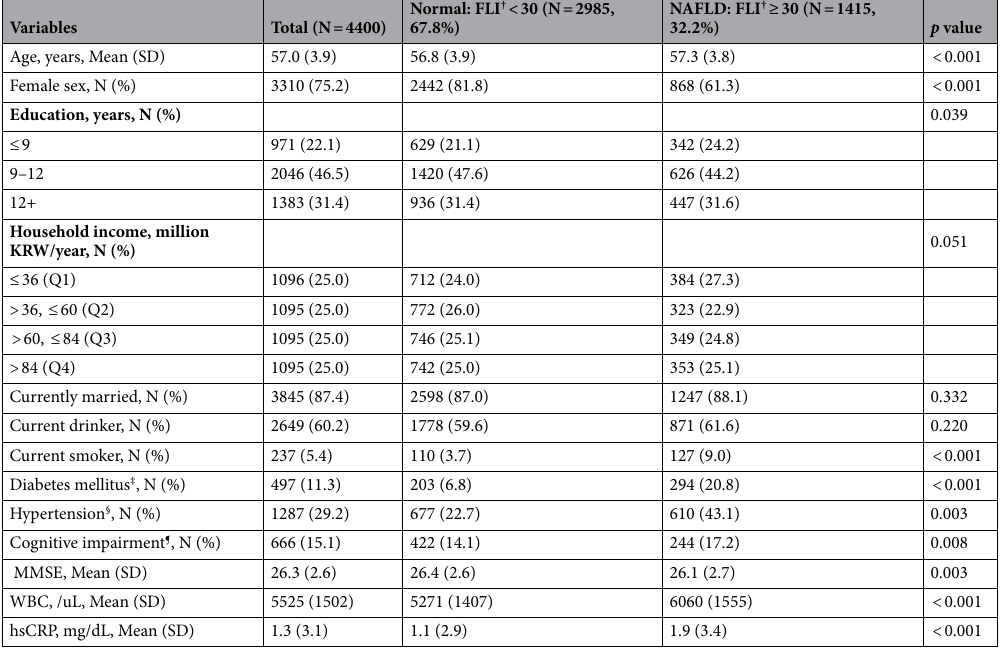
Table 1. Descriptive characteristics of the study population from Cardiovascular and Metabolic Diseases Etiology Research Center cohort (N = 4400). † FLI = 100 × e 0.953 × loge ( triglycerides ) + 0.139 × ( BMI ) + 0.718 × loge ( γ − GTP ) + 0.053 × ( waistcircumference ) − 15.745 1